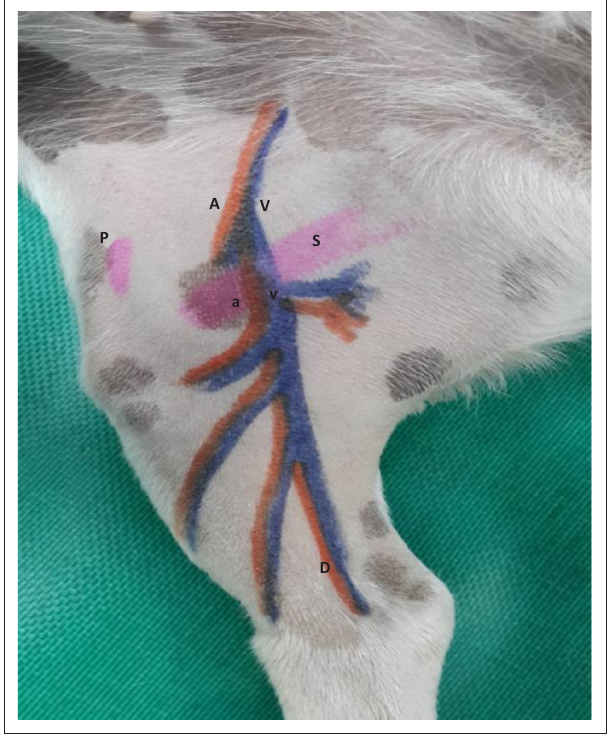
Source : Taken by Dr R.C. Elliott FIGURE 2: The anatomy of the saphenous artery and vein in relation to the reverse saphenous conduit flap, (A) femoral artery, (V) femoral vein, (P) patella, (S) Sartorius muscle, (a) saphenous artery branching from the femoral artery, (v) saphenous vein branching from the femoral vein, (D) distal communications where the blood flow will be